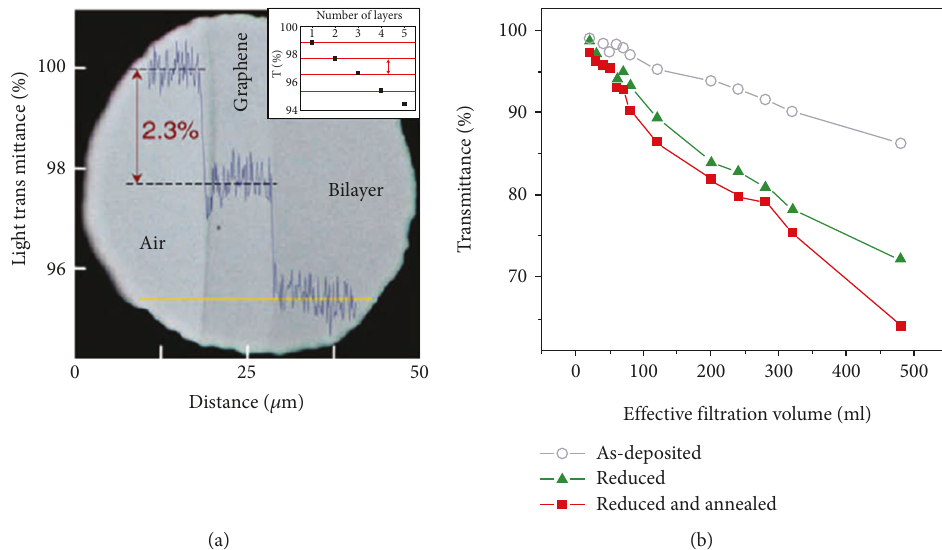
Figure 3: Optical transparency. (a) Optical micrograph of one- and two-atom-thick graphene crystals. The optical transmittance at 550 nm as a function of the lateral coordinate shows clear steps, the height of which is proportional to the hyper fi ne constant. In the inset, the linear variation of the transparency as function of number of layers is observed up to six layers. (b) Transmittance at λ ~550nm as a function of the thickness of reduced GO thin fi lms, assessed indirectly by the total volume of fi ltered suspension. Plots are shown for thin fi lms with di ff erent reduction steps